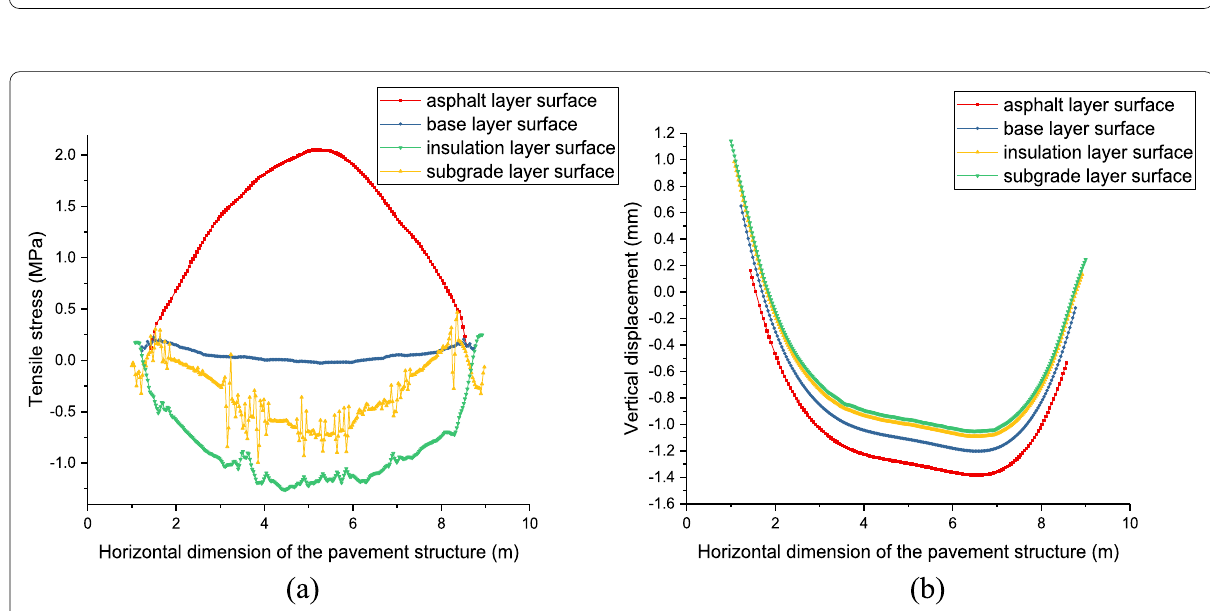
Fig. 12 a The tensile stress and b the vertical displacement in the pavement structure with glass fiber insulation layer on March 1st, 2017 at Anchorage, Alaska